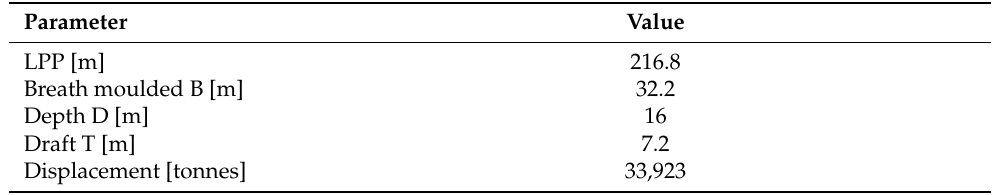
Table 6. Reference ship main particulars.